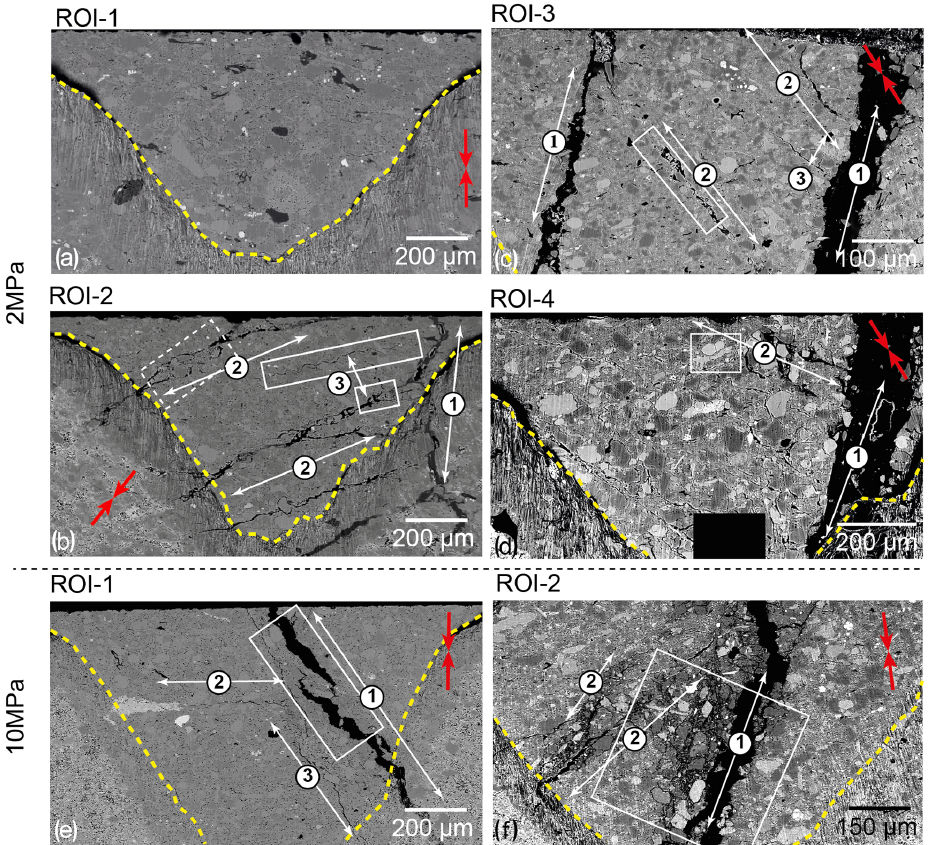
Figure 5. BSE–SEM micrographs of the BIB cross section overviews of COX-2MPa (a–d) and COX-10MPa (e–f) at differently strained areas (ROI) highlighted from DIC analysis in Figs. 2 and 3. Highly strained ROI (b–f) display damaged microstructures where three different types of fracture are identified: (1) the main synthetic fracture, (2) antithetic fractures oriented about 60 ◦ to the main fracture and (3) joints subparallel to the main synthetic fracture. These fractures are respectively indicated by numbers 1, 2 and 3 in the figure. In (b) the white box in dashed lines refers to Fig. 7f; the upper white box in solid lines refers to Fig. 7a and the lower white box in solid lines refers to Fig. 7e. In (c) the white box in solid lines refers to Fig. 7g. In (d) the white box in solid lines refers to Fig. 7c. In (e) the white box in solid lines refers to Fig. 9. In (c) the white box in solid lines refers to Fig. 11. In all micrographs, the orientation of the principal stress ( σ 1 ) is indicated by red arrows. The bedding is perpendicular to σ 1 . Dashed yellow lines indicate the boundaries of the BIB-polished